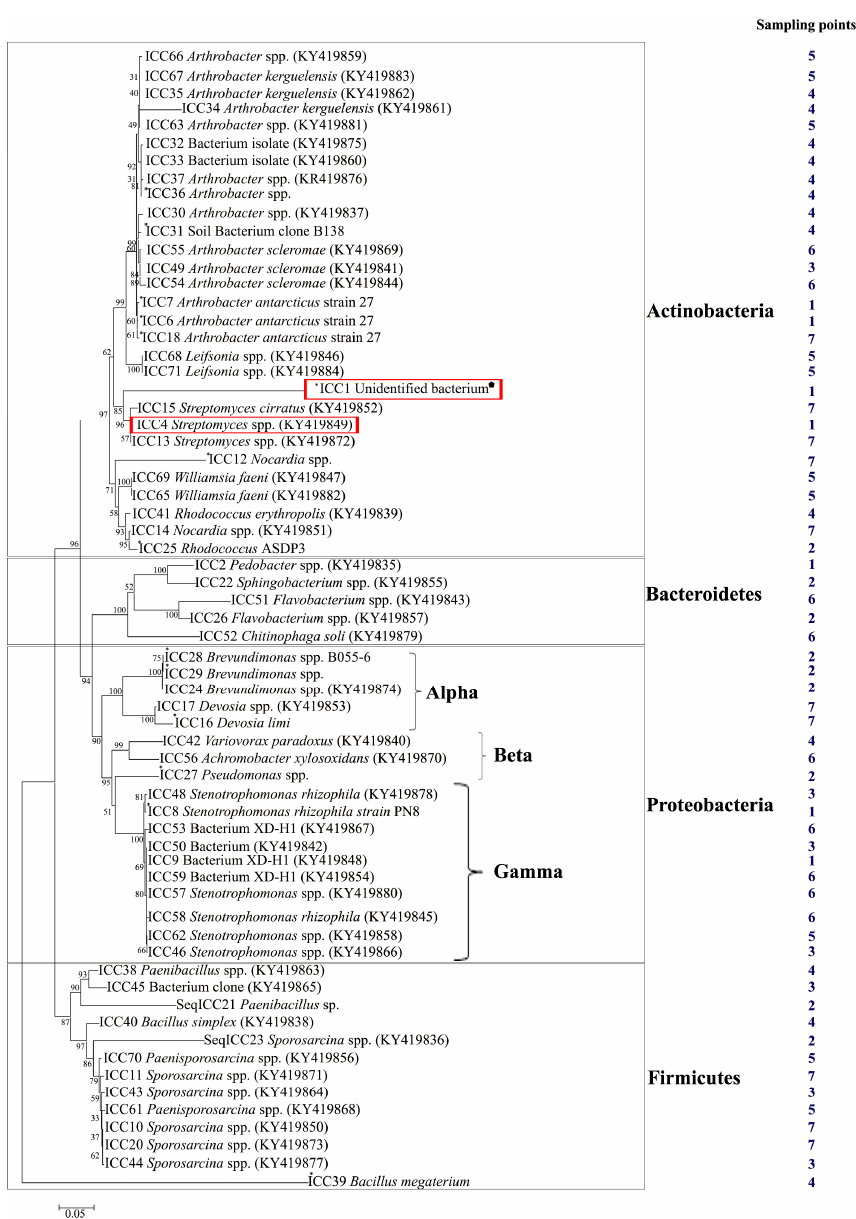
Figure 5. Evolutionary relationships of taxa. The 16S rRNA gene sequences obtained from the NCBI gene database were aligned by MUSCLE with default parameters. The phylogenetic tree was constructed using MEGA6 by neighbor-joining method, with a bootstrap test of 1000 replicates. The asterisk (*) denotes the sequences that were not assigned with a GenBank accession number. The red boxes represents the bacterial isolates that exhibited antimicrobial properties. The polygonal ( ) represents the ICC1 having an identity of 73% to Streptomyces nojiriensis .